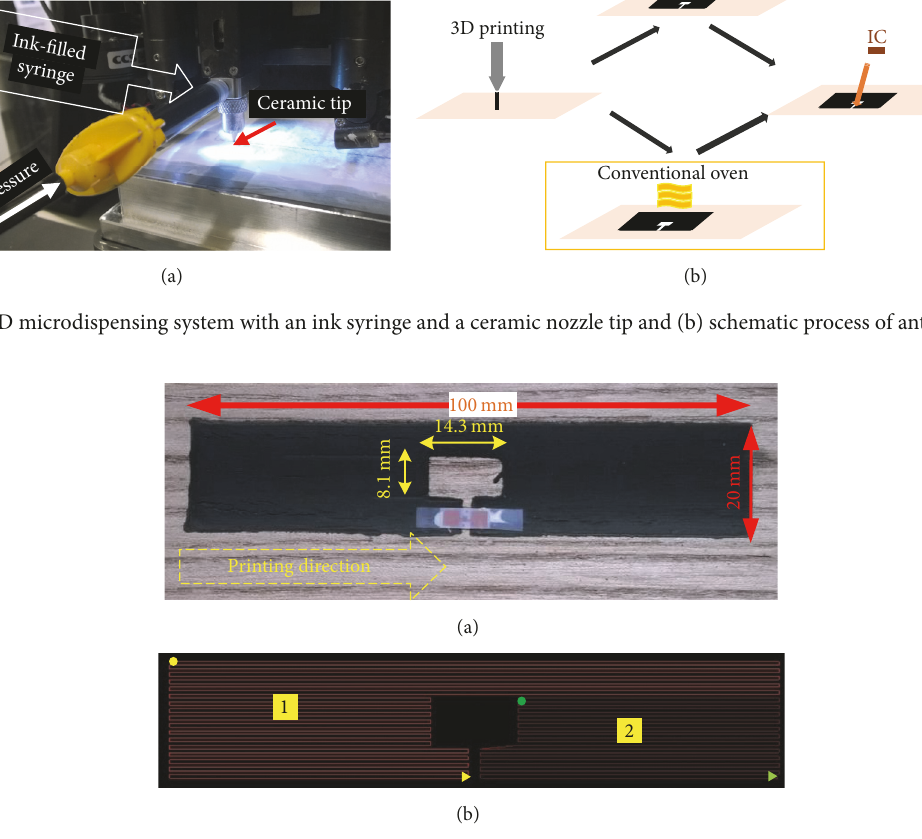
Figure 2: (a) 3D-printed RFID tag antenna (one layer) on wood and (b) image of printing